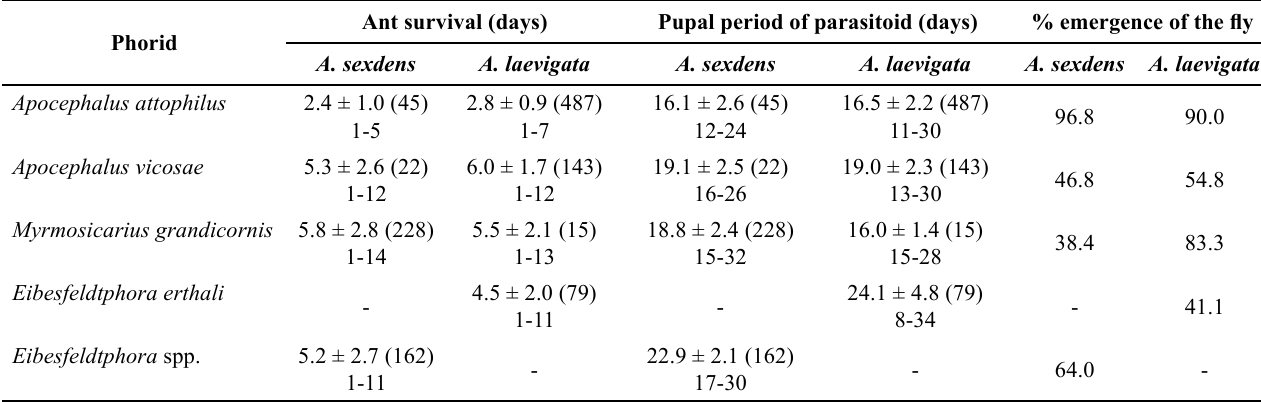
Table 2 . Survival in laboratory of workers of the leaf-cutter ants Atta sexdens and Atta laevigata parasitized by different phorid species, the pupal duration of these species and the percent of emergence of these parasitoids. Means are shown ± SD with number of individuals in parentheses followed by the range in the next